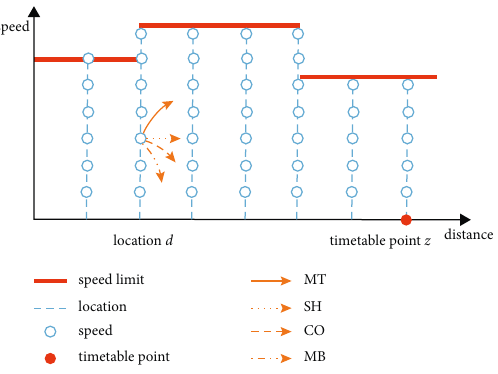
Figure 3: Example of